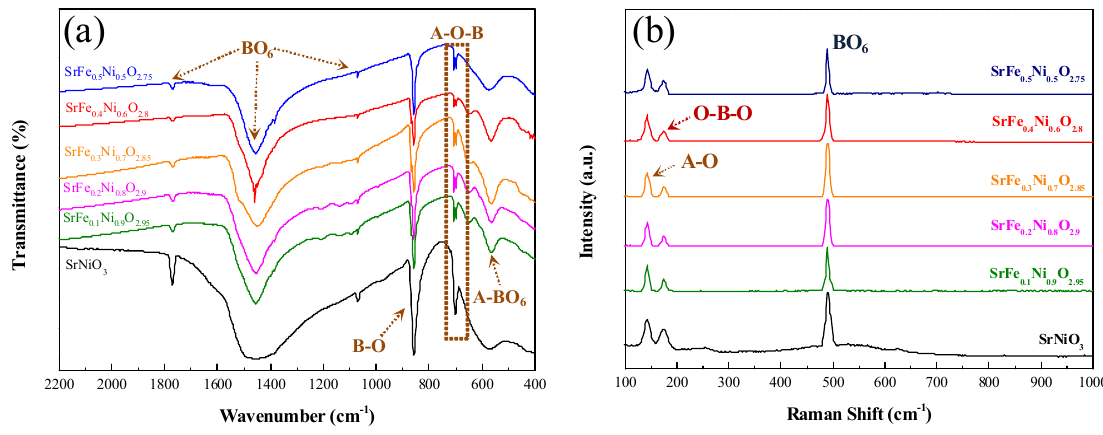
Figure 11. FT-IR ( a ) and Raman ( b ) spectra of SrFe x Ni 1 − x O 3 − δ.